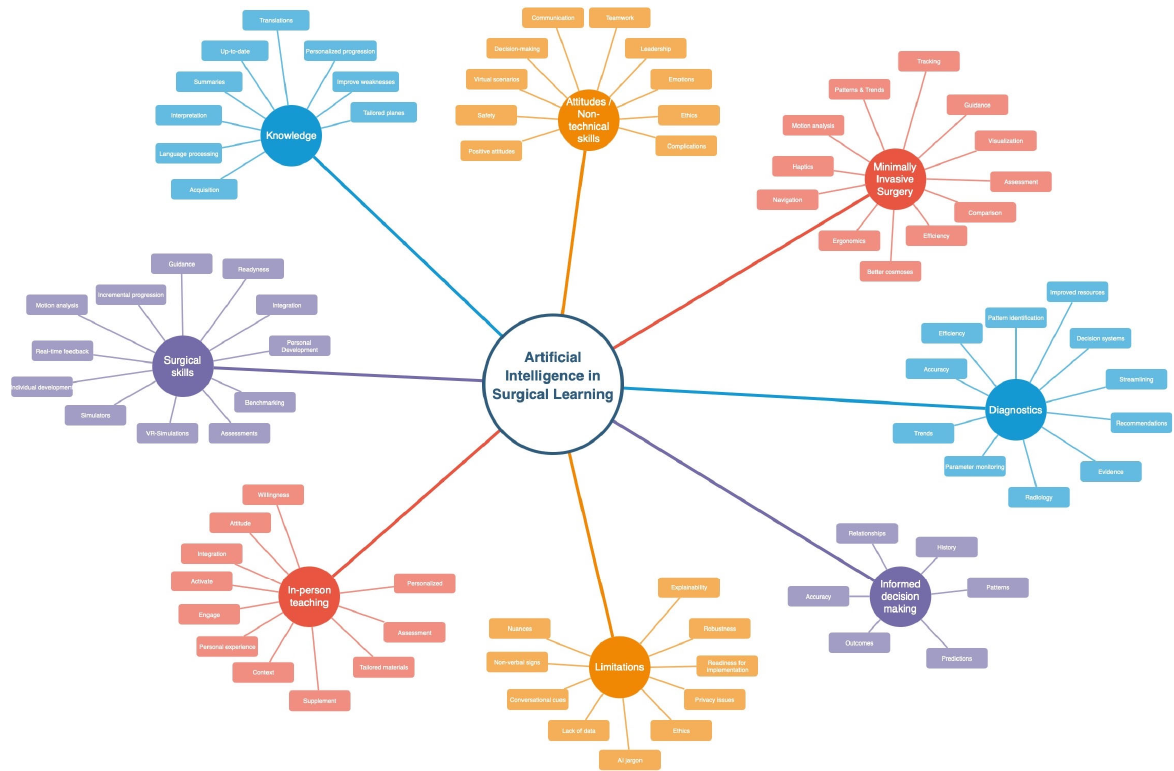
Figure 2. Applications and limitations of AI in surgical learning.